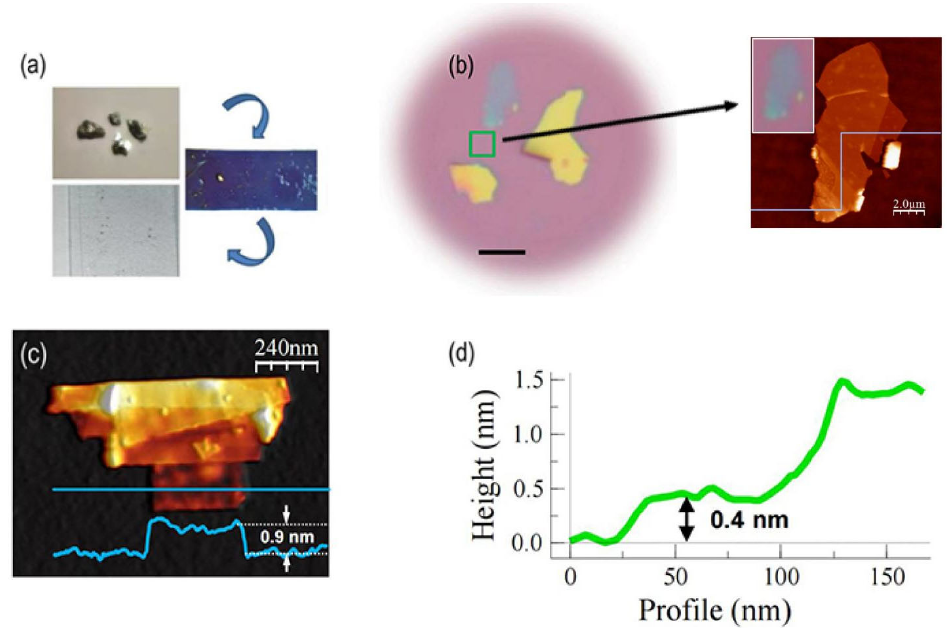
Figure 2. ( a ) Exfoliation process of antimonene; ( b ) optical microscope images. The illustration is a larger view of the green box; ( c ) AFM appearance map; ( d ) the minimum thickness of the peel is 0.4 nm. Reprinted with permission from Ref. [39]. Copyright 2016, John Wiley and Sons.